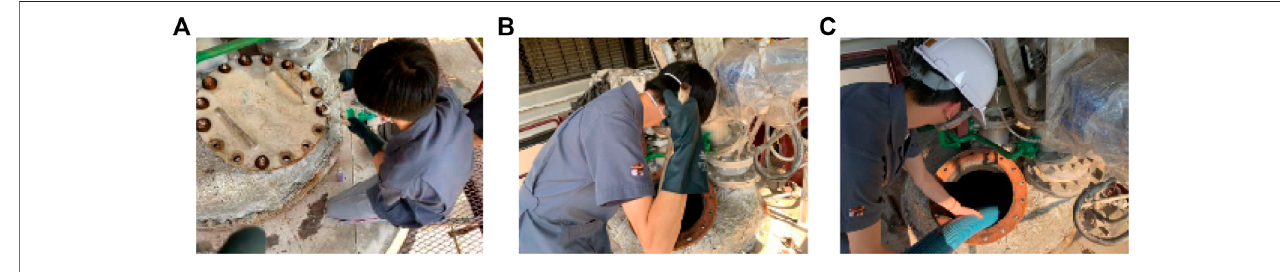
FIGURE 2 | Preparation of the coolant (A) Taking remain water out of the coolant tank and (B) Adding new water into the tank.